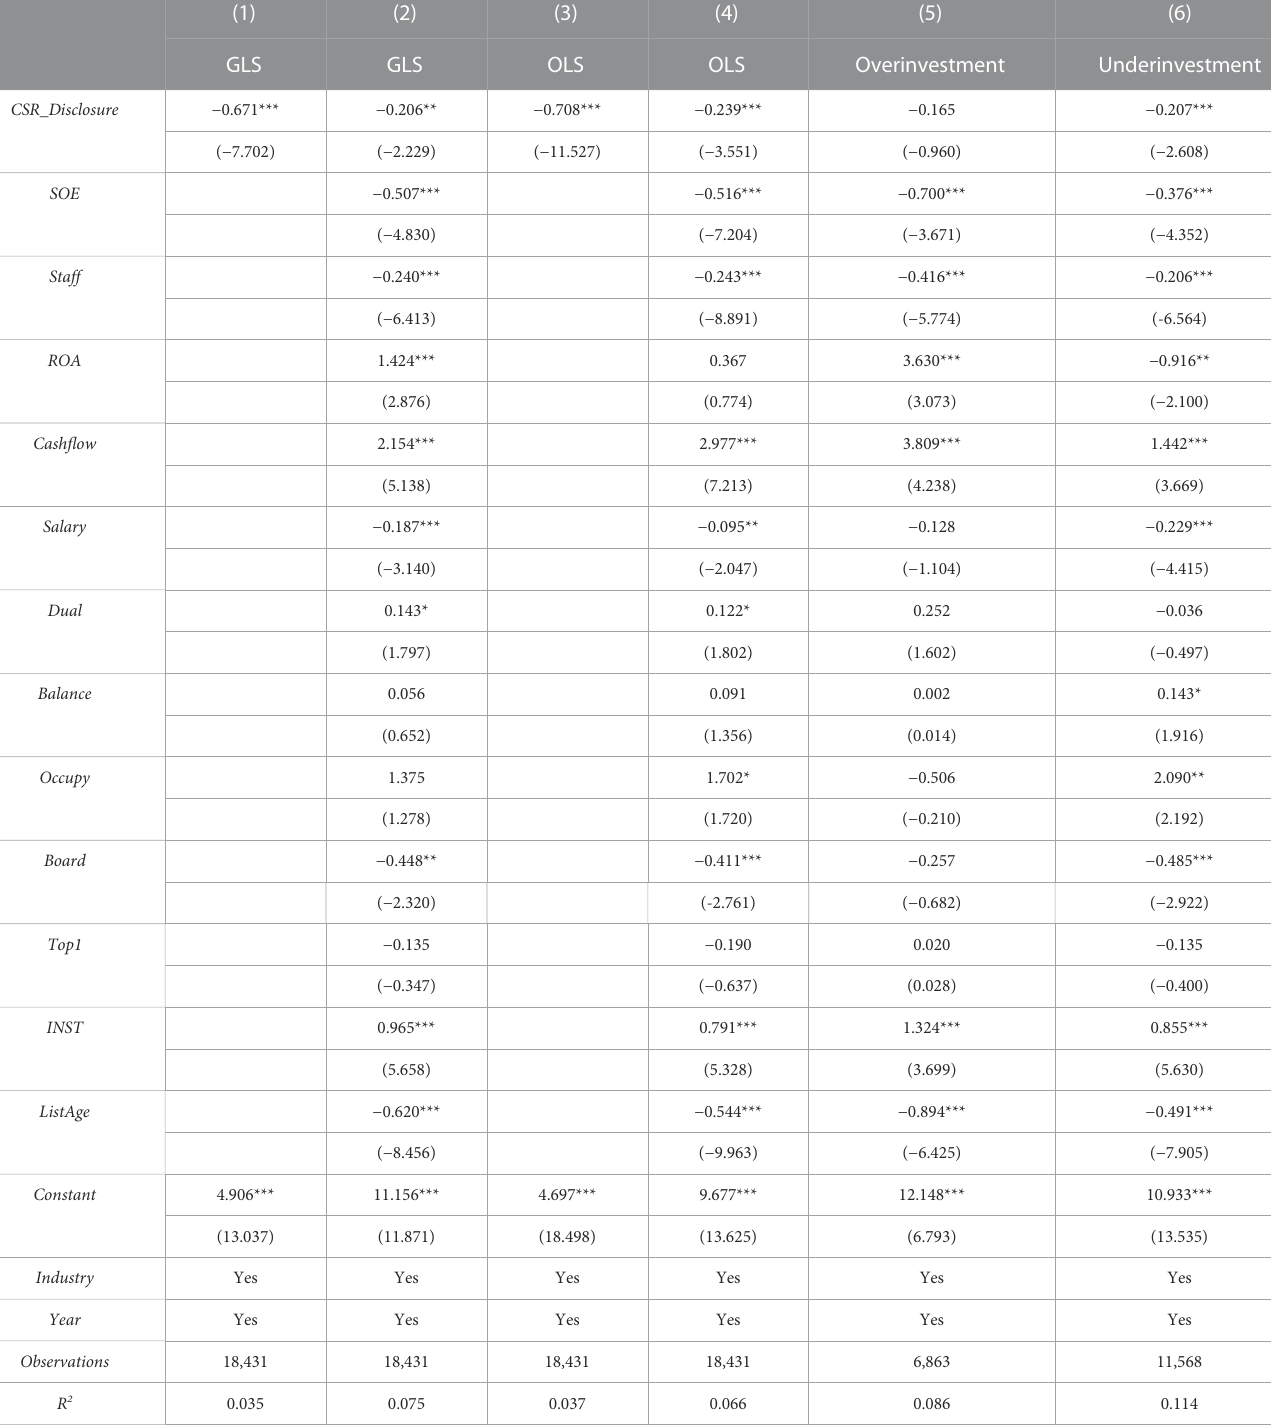
TABLE 4 Regression results of the impact of CSR disclosure on investment ef fi